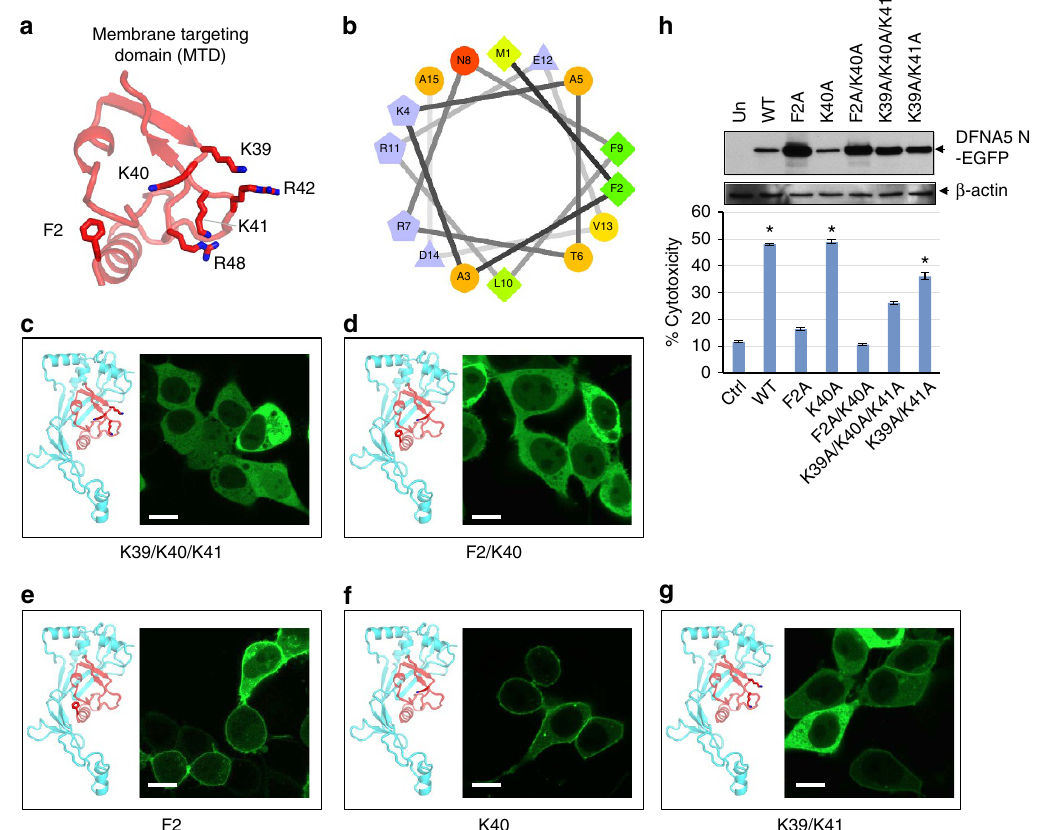
Figure 4 | Molecular determinants of plasma membrane targeting of DFNA5-N. ( a ) Predicted structure of DFNA5 MTD spanning residues 1–57 showing the side chains of residues F2, K39, K40, K41, R42 and R48 as sticks. ( b ) Helical wheel representations of DNFA5 residues 1–14 showing the putative amphipathic nature of the N-terminal helix. K4, R11 and R7 are clustered on the left while F2 and F9 are on the right hand side of the helix. ( c – g ) Confocal images of the indicated DFNA5-N-EGFP alanine mutants expressed in 293T. The ribbon diagrams on the left of each image show the position of side chains of residues mutated to alanines. Scale bar, 10 m m. ( h ) Cytotoxicity of the indicated DFNA5-N mutants as measured by LDH release in the culture supernatants of 293T cells transfected with constructs encoding these mutants ( n ¼ 3). * P o 0.001, Student’s t -test. Expression of these mutants in cell lysates is shown in the top panel as measured by immunoblot analysis with anti-DFNA5 antibody. Results are representative of at least three independent experiments. Error bars represent standard error of the mean